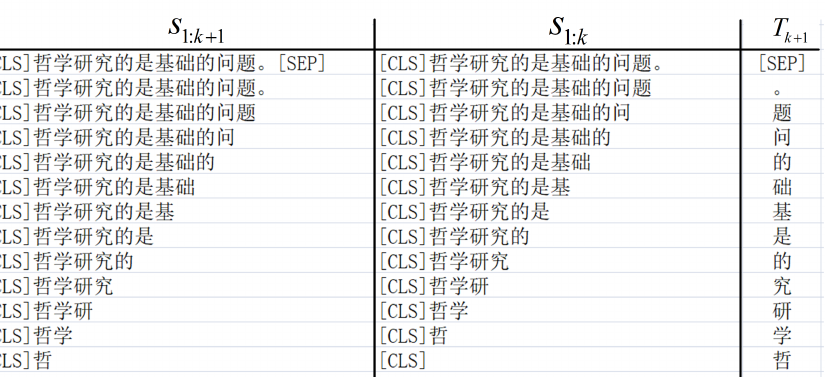
Figure 6. The construction of the dataset used to train SEMTS-BERT. The symbols s 1: k + 1 , s 1: k , and T k + 1 are defined in Figure 5. [CLS] and [SEP] are two special characters used to enclose